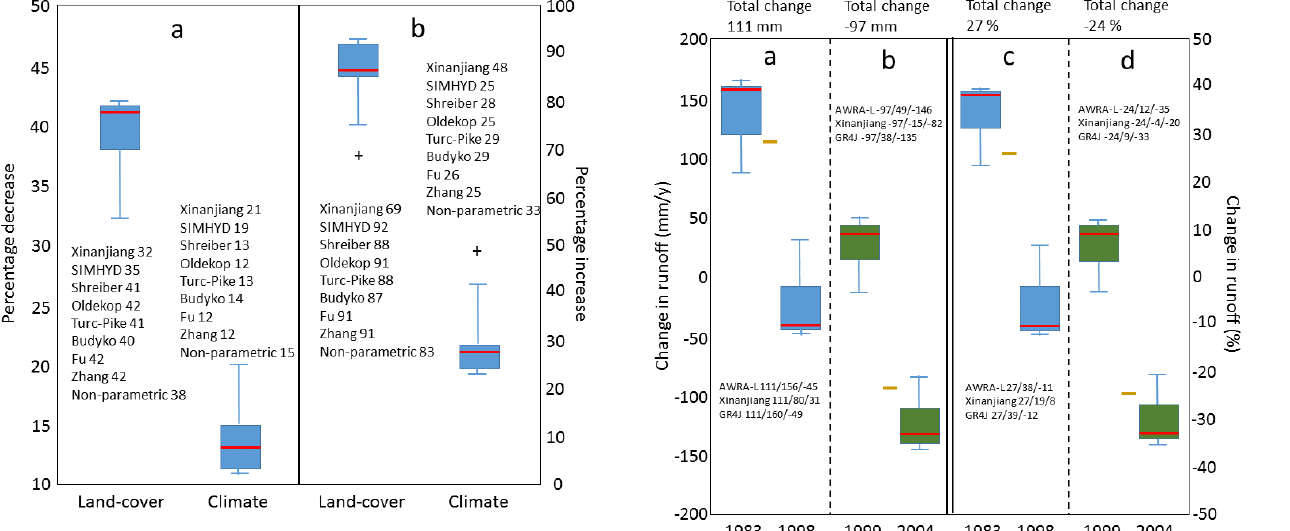
Figure 2. Percentage (a) reduction/ (b) increase in streamflow dur- ing the afforested/pre-afforestation period due to increase/decrease in plantations and drier/wetter climate estimated by the nine ap- proaches.